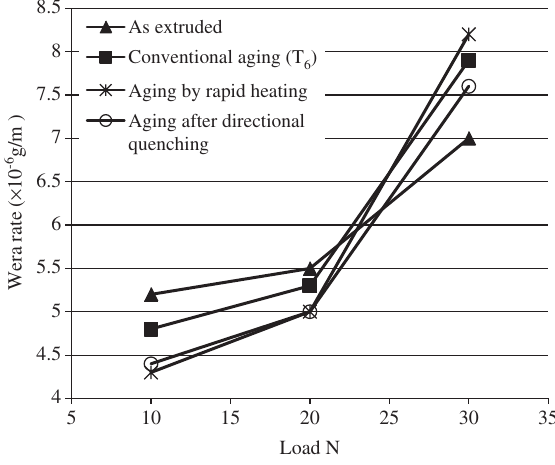
Figure 11: Results of wear rate of AA8090/6% SiC different conditions at 30 N load.